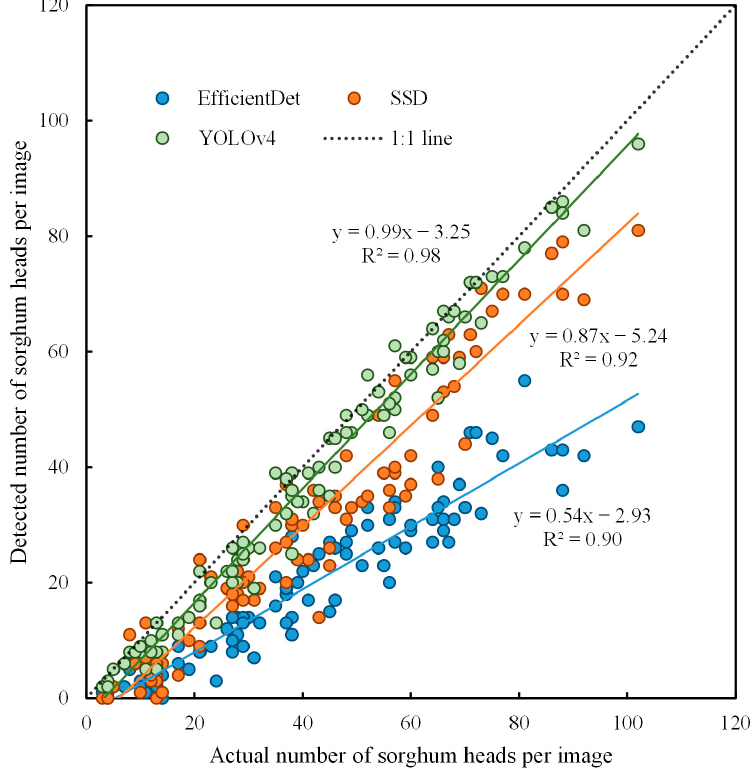
Figure 8. Comparison between the actual number and detected number of sorghum heads per test image using different deep learning